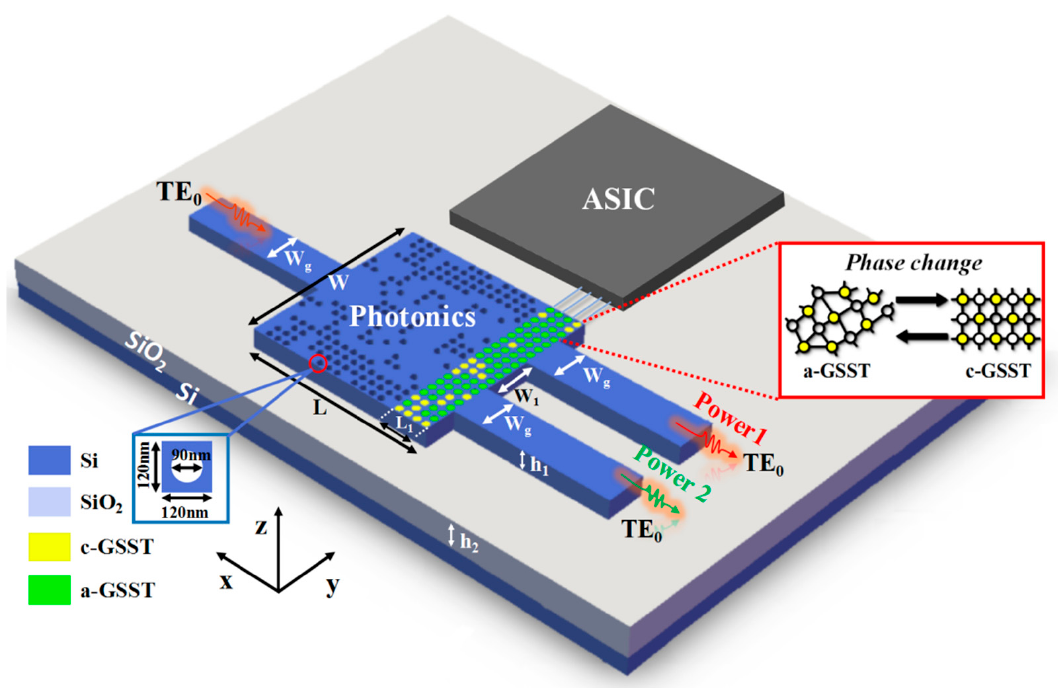
Figure 1. Schematic of the 1 × 2 photon programmable power splitter. Transverse electric (TE 0 ) mode waves within a wavelength range of 1530–1560 nm were input from the left port. After these waves passed through the coupling region, the TE 0 mode waves with Power1 and Power2 split ratios were output from the upper and lower channels on the right, respectively. The splitting ratio was regulated by the state of the phase-change material controlled by an electronic circuit program.